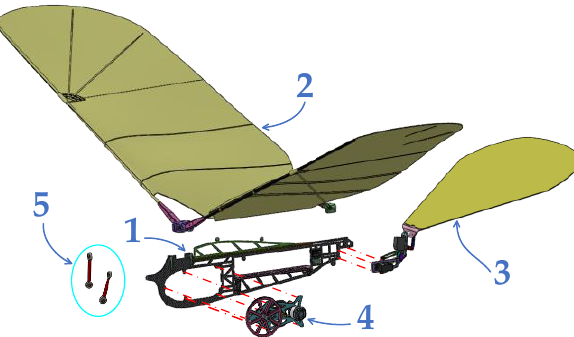
Figure 1. The overall structure of the HIT-Hawk.